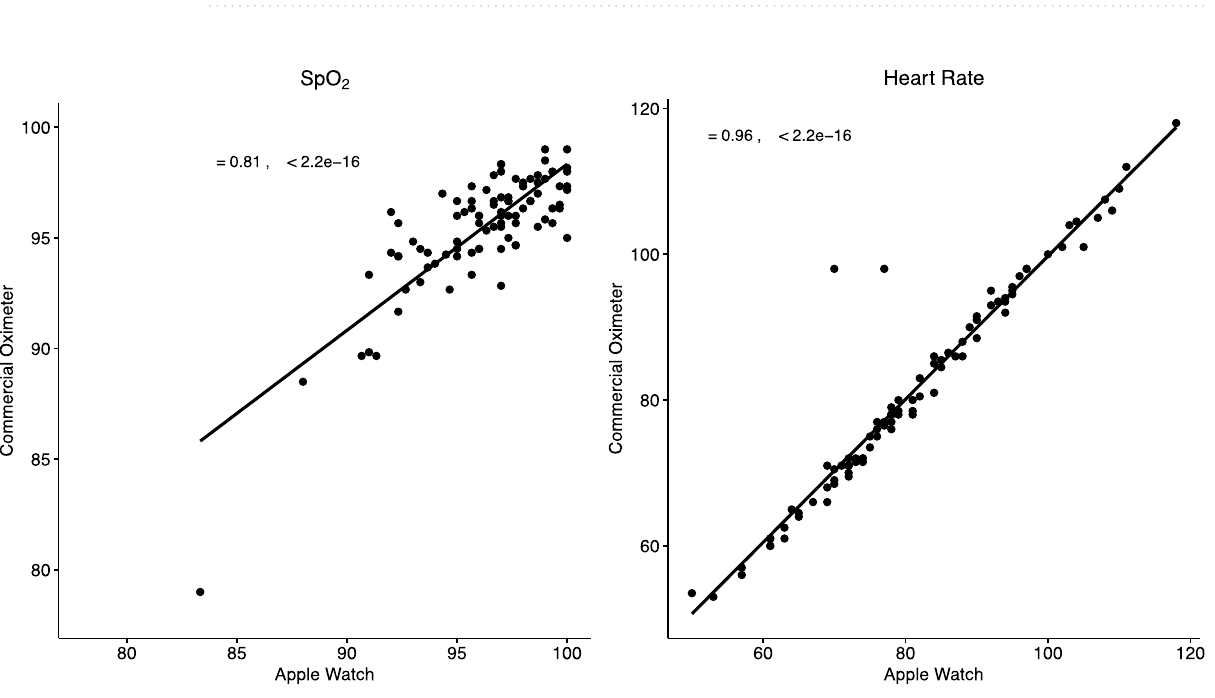
Figure 1. Correlation plots of SpO 2 (r = 0.81) and heart rate (r = 0.966) of COPD and ILD patients and healthy